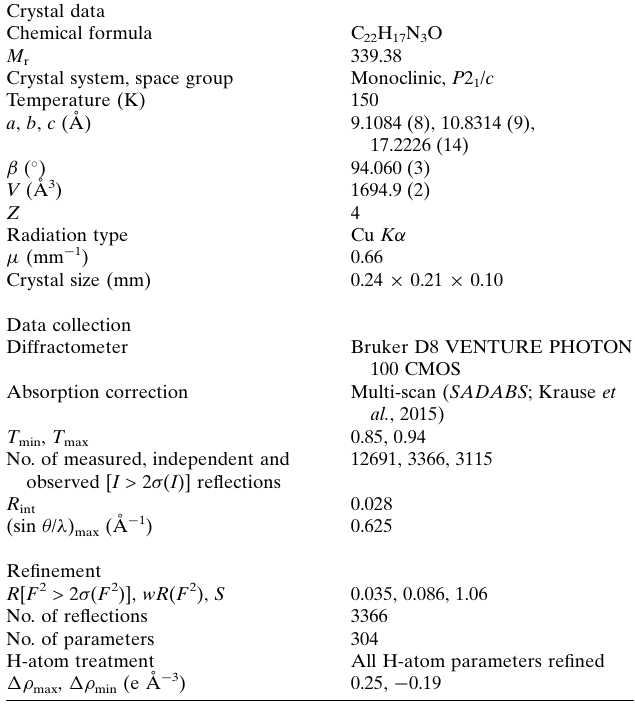
Table 2 Experimental details.